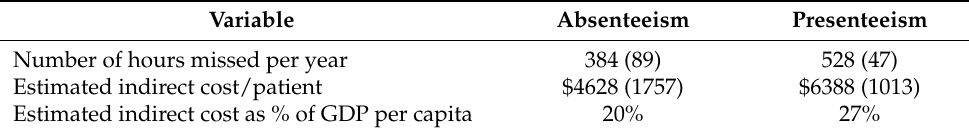
Table 3. The estimated indirect cost associated with heart